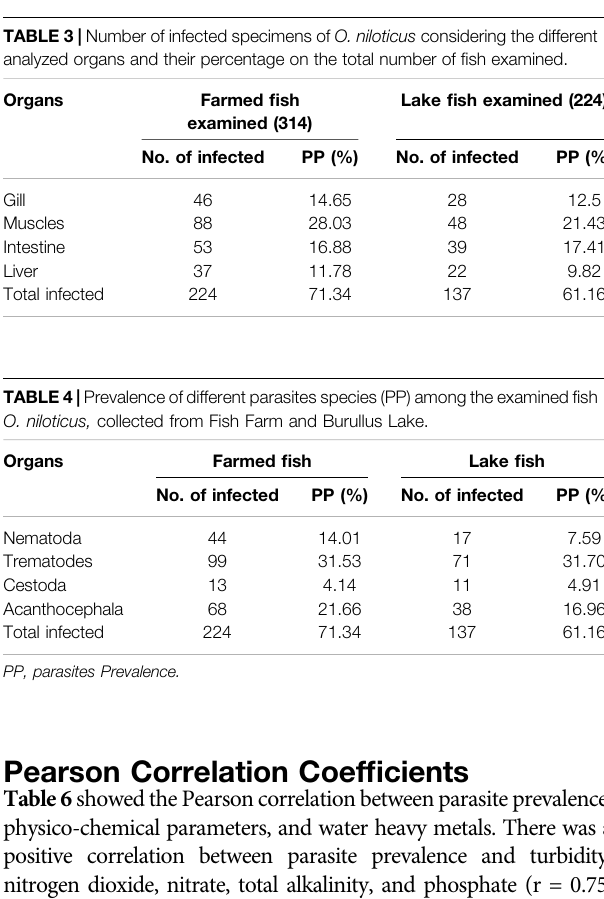
Table 6 showed the Pearson correlation between parasite prevalence, physico-chemical parameters, and water heavy metals. There was a positive correlation between parasite prevalence and turbidity, nitrogen dioxide, nitrate, total alkalinity, and phosphate (r = 0.75, 0.69, 0.65, and 0.67; p < 0.05). The parasite prevalence of farmed and